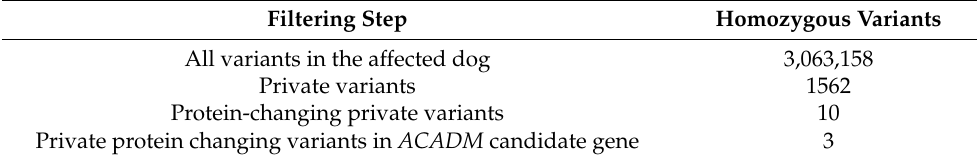
Table 1. Results of variant filtering in the affected dog against 923 control